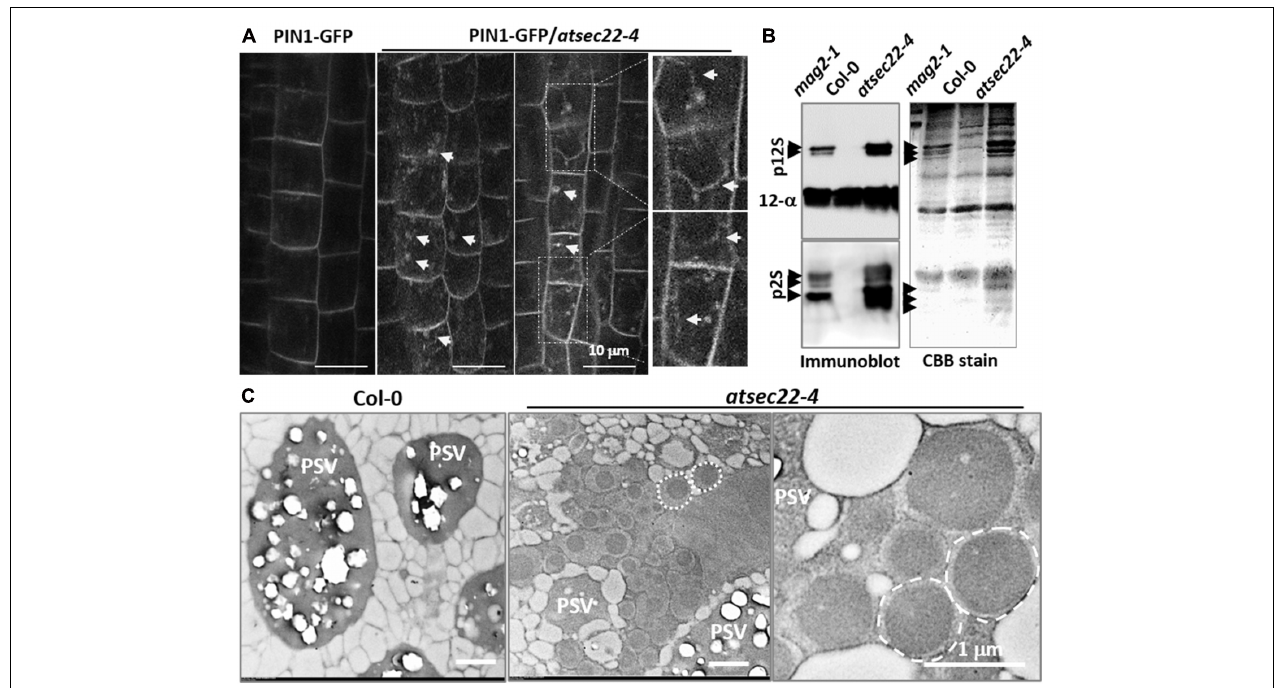
FIGURE 3 | Vesicle trafficking was disturbed in atsec22-4. (A) PIN1-GFP were internalized in root cells in atsec22-4 (arrows). Magnified images emphasize multiple localization of PIN1-GFP (arrows). (B) Immunoblot of seed proteins with anti-12S globulin and anti-2S albumin antibodies (left) , and total seed protein profiles (CBB-stained SDS-PAGE gel) (right) . The atsec22-4 seeds accumulated numerous SSP precursors (arrows). mag2-1 was used as positive control, Col-0 was used as negative control. p12S, 12S globulin precursors; p2S, 2S albumin precursors; 12S- α , 12S globulin α subunits. Scale bars are as shown. (C) TEM images of dry seed cells. Unusual structures (dotted circles) with a high electron-dense core were developed in atsec22-4 seed cells. PSV, protein storage vacuole.